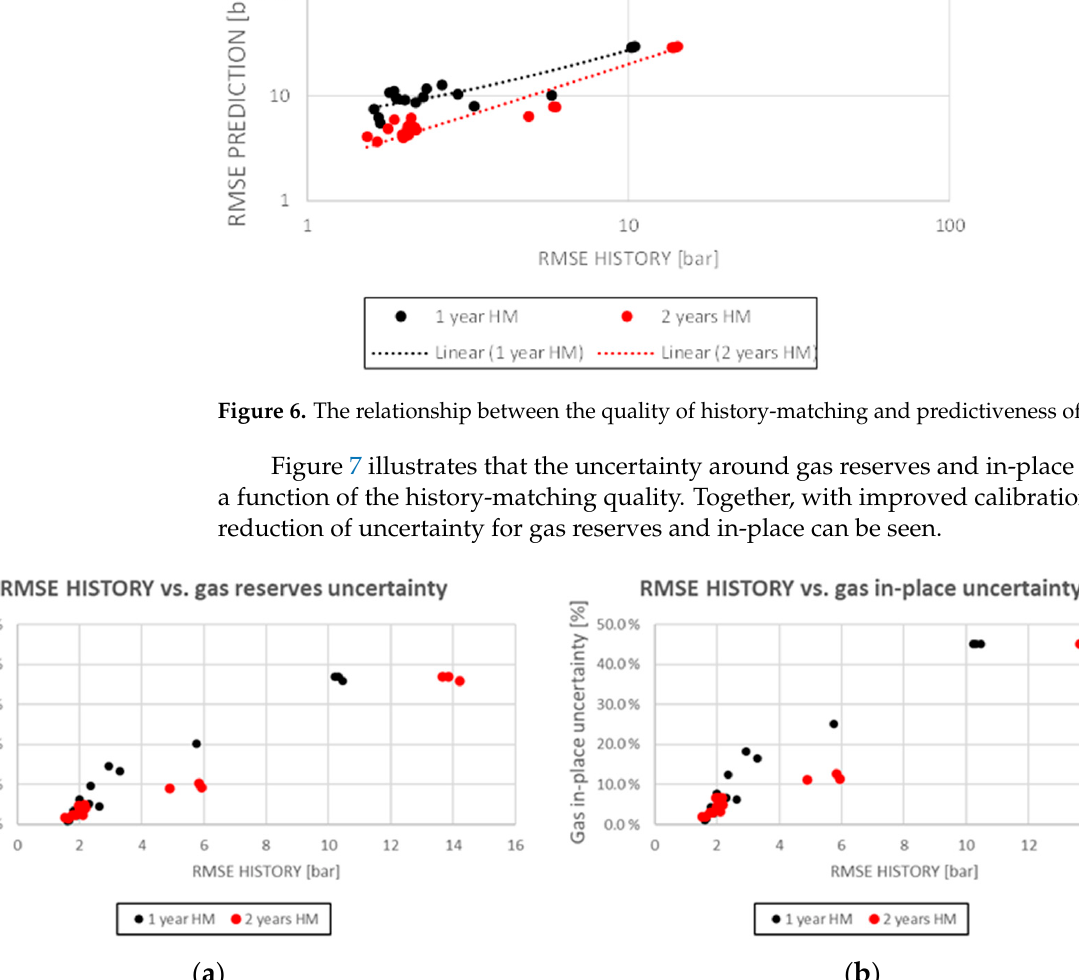
Figure 5. The change of normalized parameters affecting pressure development in the reservoir,